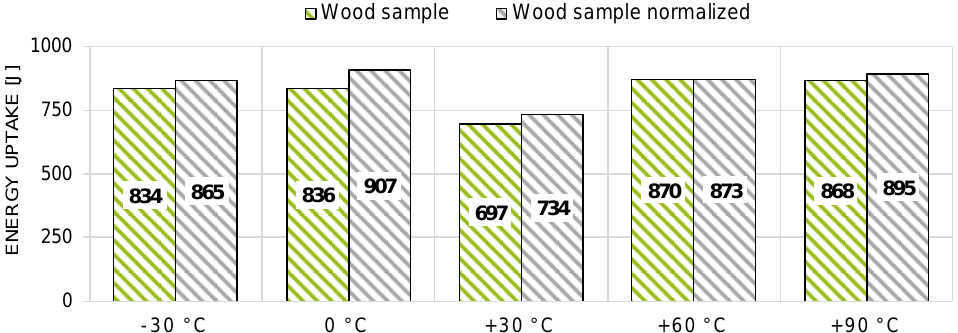
Figure 16. Comparison between the dynamically tested mean energy uptake of the wood samples against a normalized mean energy uptake.